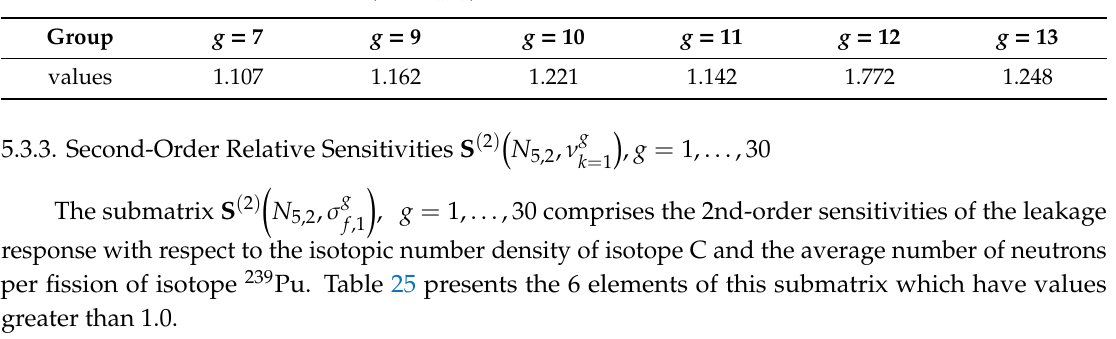
Table 24. Elements of S ( 2 )